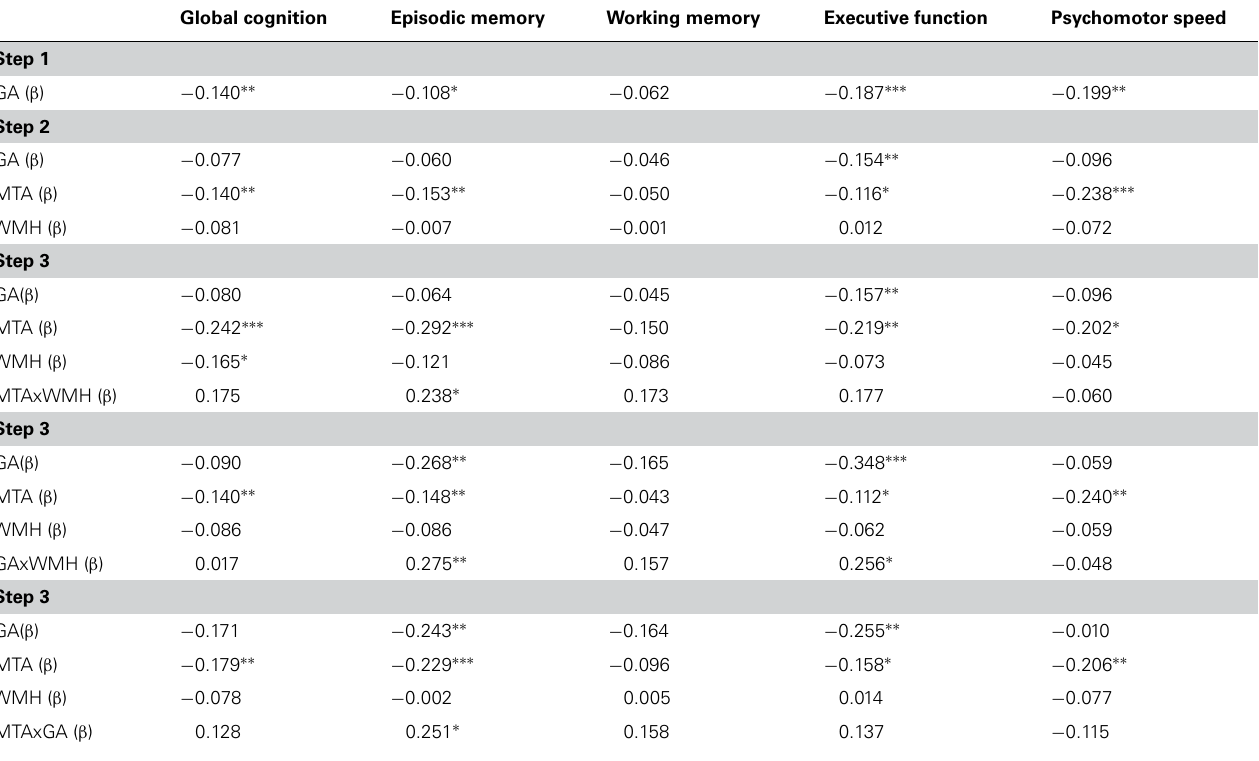
Table 3 | Main and interaction effects ofWMH, GA, and MTA in relation to the different cognitive domain